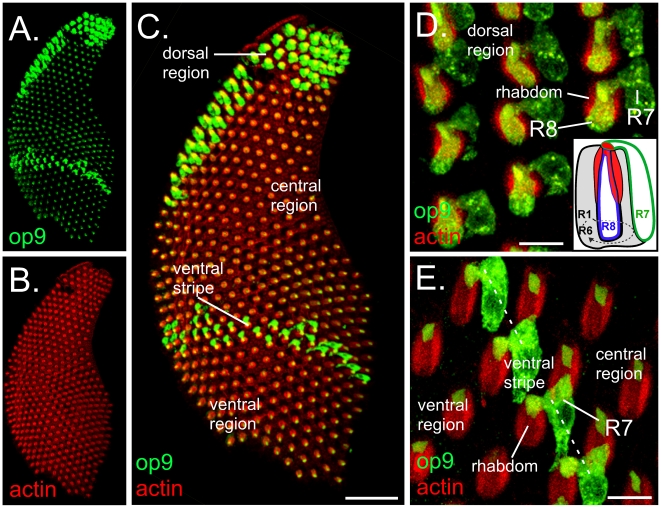
Aaop9 rhodopsin is expressed in all R7 and a subset of R8 photoreceptor cells in Ae. aegypti.A–C. Whole mount retina of Ae. aegypti stained with Aaop9 antibody (A, green), phalloidin (B, red), and the resulting merged image (C). Phalloidin detects actin and heavily stains the fused rhabdom of all ommatidia. Aaop9 shows different expression profiles in the regions of the Ae. aegypti retina labeled as the dorsal region, central region, ventral stripe, and ventral region in C. The scale bar shown in C is ∼50 µm. D. A magnified view of the dorsal region of the Ae. aegypti retina. In one ommatidium the rhabdom and the R7 and R8 cell bodies are identified. Aaop9 rhodopsin (green) is expressed in the R8 cell positioned centrally within the rhabdom and in the R7 cell projecting a rhabdomere at the distal surface of the rhabdom. The inset drawing shows a single ommatidial unit oriented in a similar fashion as those in the micrograph. The fused rhabdom is shown in red, the R7 cell (green) projects a distal rhabdomere and the R8 cell (blue) occupies the central area inside the rhabdom. The R1–6 cell bodies (grey) surround the rhabdom. In this dorsal region, Aaop9 rhodopsin is localized to the cell bodies and rhabdomeres of the R7 and R8 photoreceptors. The scale bar shown is ∼10 µm. E. A magnified view of the ventral stripe region of the Ae. aegypti retina. In one ommatidum within the ventral stripe the R7 cell body is identified. In the central and ventral regions on either side of the ventral stripe, Aaop9 rhodopsin (green) is expressed only in the R7 rhabdomere. Within the ventral stripe, Aaop9 rhodopsin is expressed in R7 cell body (labeled) and the R7 rhabdomere. The rhabdom (red) is labeled; the orientation of ommatidia is similar to the inset drawing shown in Fig. 2D. Scale bar is ∼10 µm.